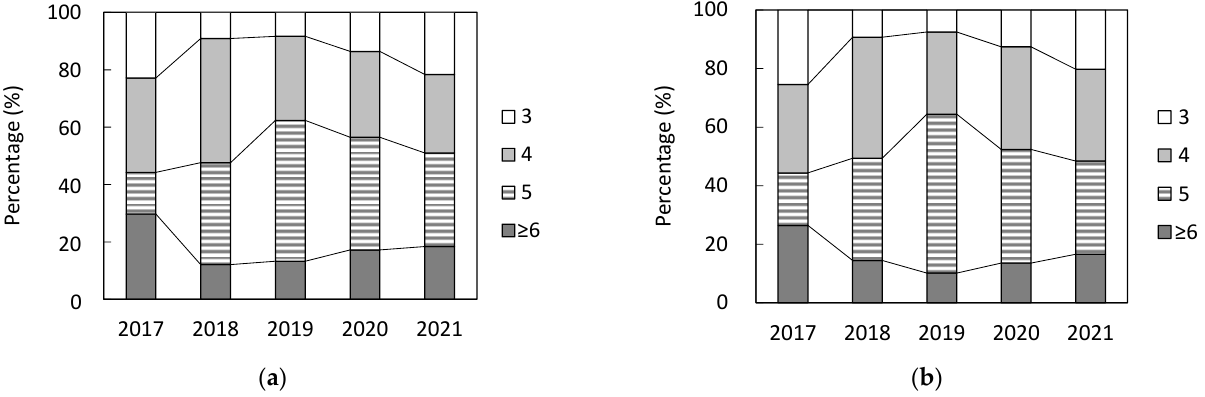
Figure 9. Behaviors in composition of PAHs by ring number: ( a ) suburban site; ( b ) forest site.